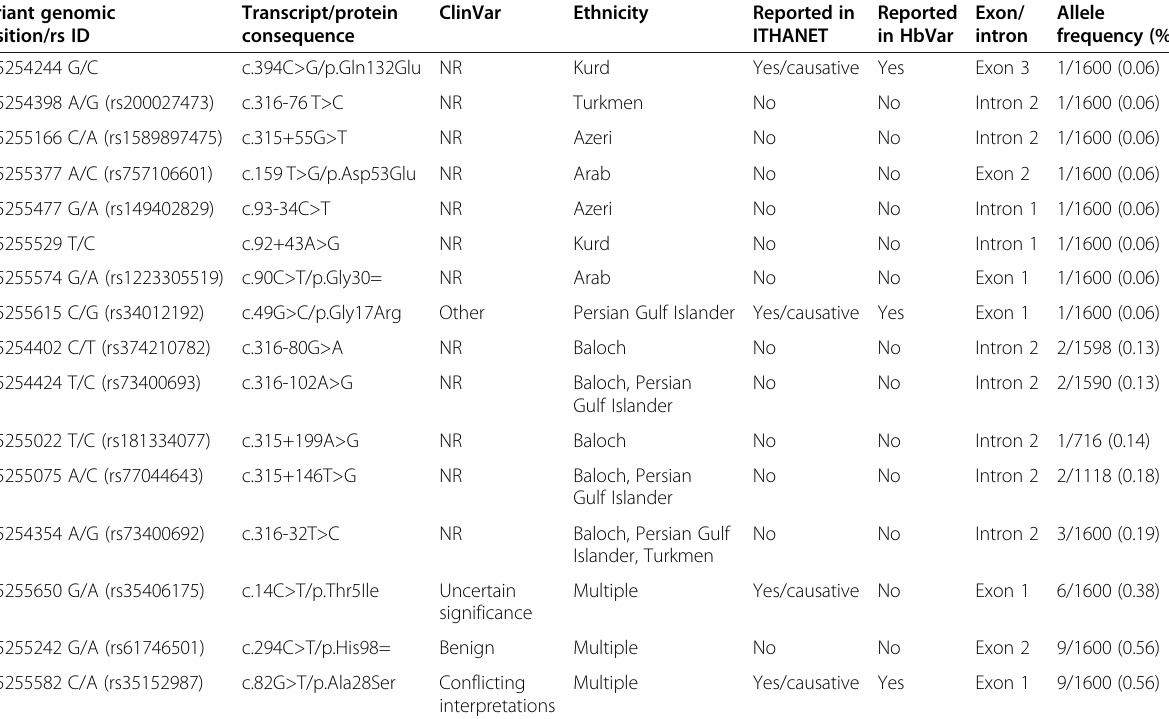
Table 1 Variants observed in the HBD gene in the Iranian population, based on Iranome project (http://www.iranome.ir/) Variant genomic Transcript/protein position/rs ID